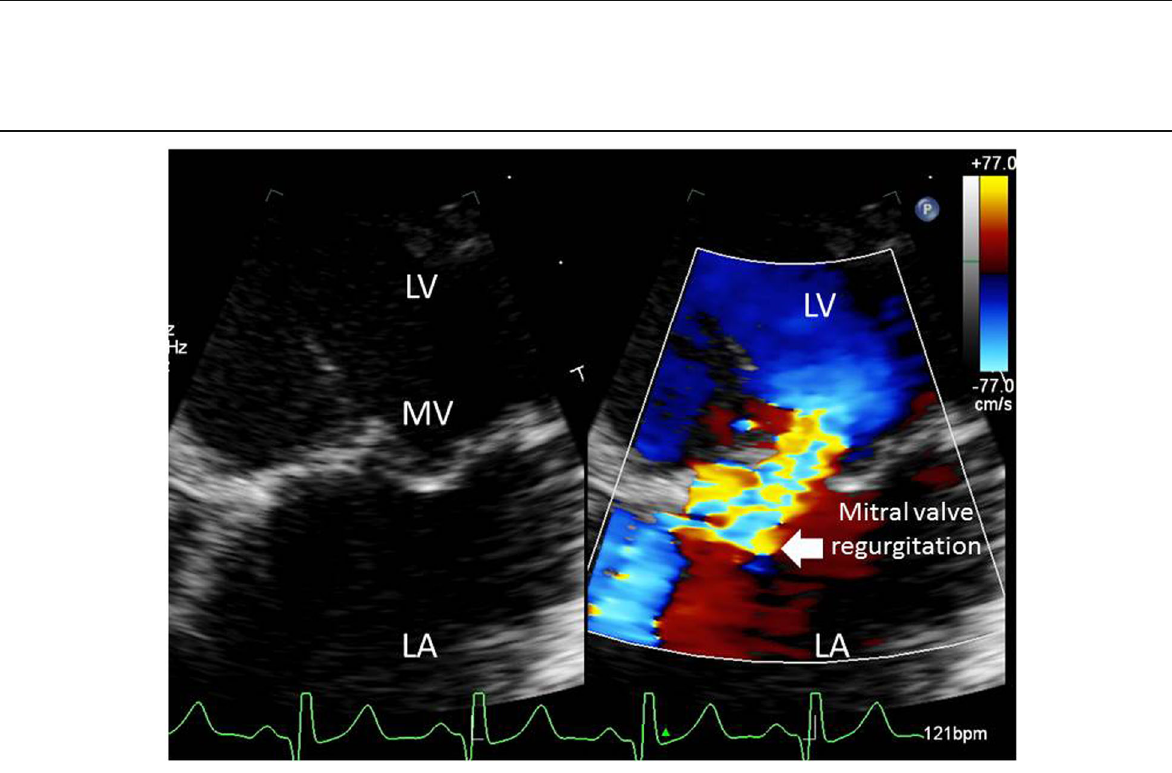
Fig. 4 Doppler profile obtained at the mitral valve, showing severe